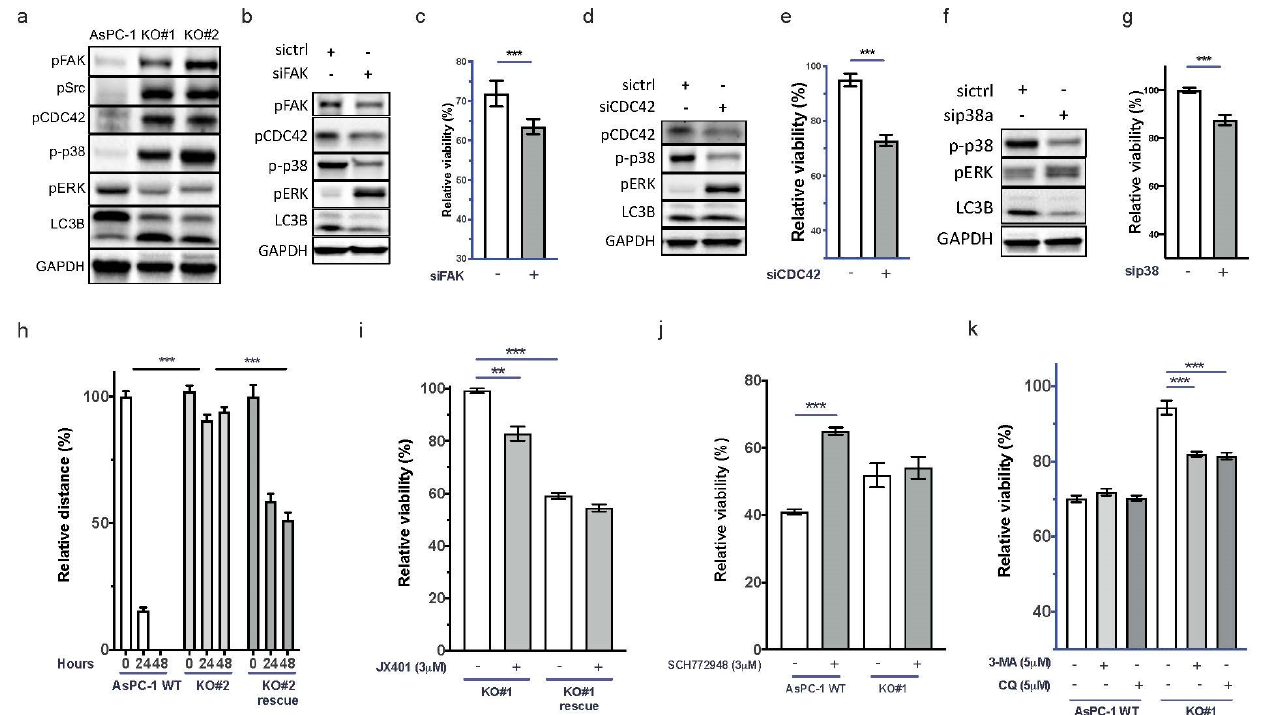
Figure 3. uPAR regulates CDC42, p38, LC3B, and ERK activity. ( a ) Immunoblot showing increased signals for pCDC42, pSrc, p-p38, pERK, and LC3B in KO#1 and KO#2.). Uncropped Western blot images could be found at in Supplementary File S1. Restoration of ( b ) the wild-type signaling phe- notype after FAK siRNA knockdown in AsPC-1 uPAR -/- cells and ( c ) of the response to gemcitabine ( n = 4). Uncropped Western blot images could be found at in Supplementary File S1 ( d ) Knockdown of CDC42 by siRNA and ( e ) response to gemcitabine and ( f ) siRNA knockdown of p38 and ( g ) the corresponding gemcitabine response. Uncropped Western blot images available in Supplementary File S1. ( h ) Increased cellular motility after transient uPAR expression in KO#2 (KO#2 rescue) com- pared to AsPC-1 uPAR -/- cells ( n = 4). ( i ) Gemcitabine (0.1 µM) and combinational treatment with the p38 inhibitor JX401 for 72 h in AsPC-1 uPAR -/- and KO#1 uPAR rescue cells ( n = 3). ( j ) Gemcitabine (0.1 µM) and combinational treatment with the ERK inhibitor SCH772948 in uPAR WT and AsPC- 1 uPAR -/- cells (KO#1). ( k ) Treatment of AsPC-1 WT and AsPC-1 uPAR -/- (KO#1) with either gemcita- bine (0.1 µM) or in combination with the autophagy inhibitors 3-MA (5 µM) or CQ (5 µM). Relative viability is shown in response to gemcitabine and in combination with siRNA/inhibitors. ( n = 4 bio- logical replicates (** p < 0.01, *** p < 0.001).